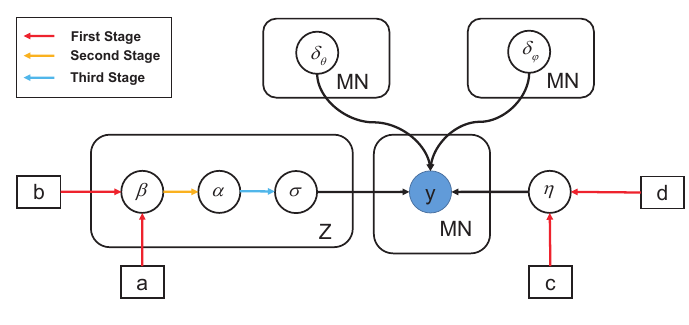
Figure 2. The three-stage sparse prior